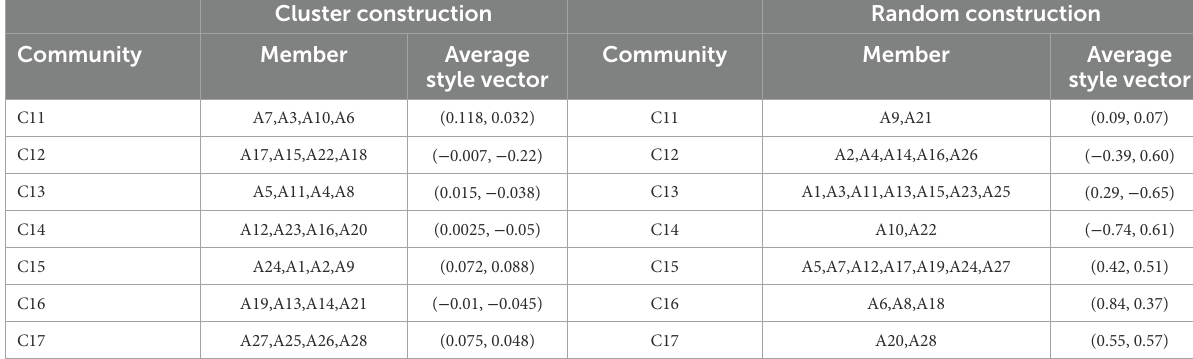
TABLE 3 Comparison of community construction